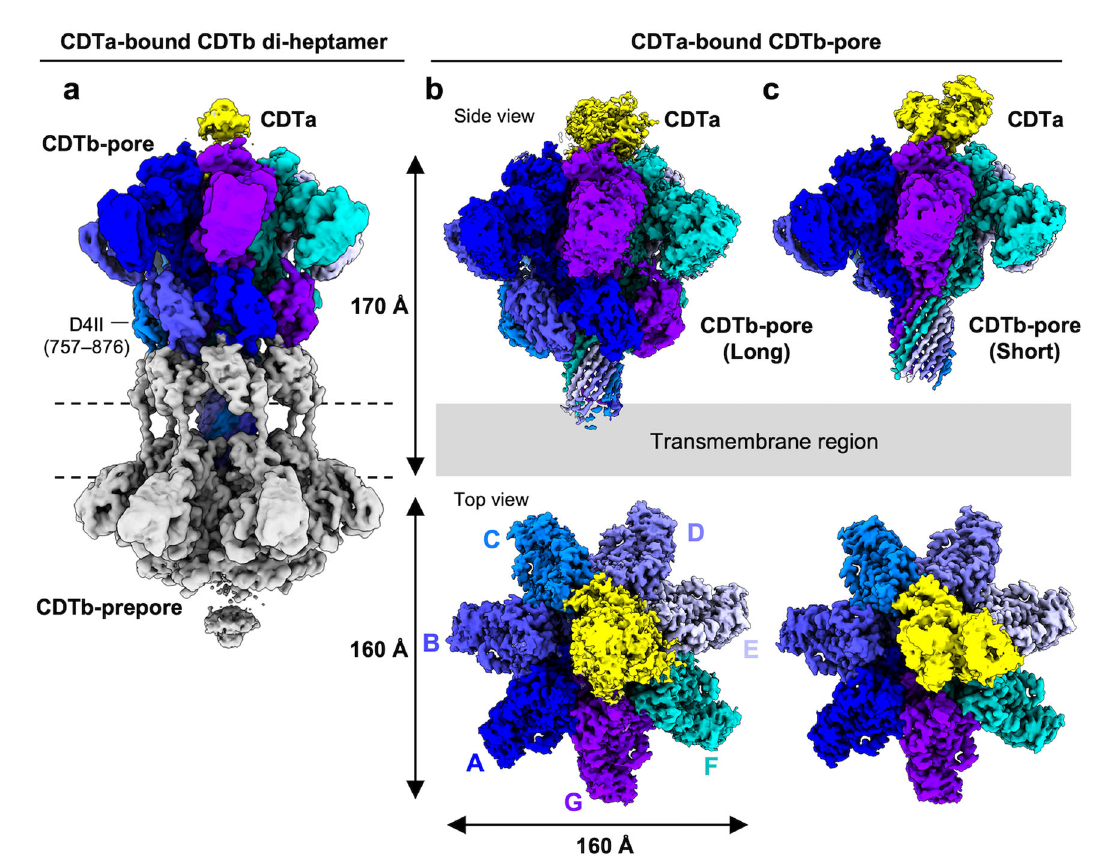
Fig. 2 | Cryo-EM density maps of CDTa-bound CDTb-pores. Transmembrane regionisshownasdottedlines(left)orgrayrectangle (right). a CDTa-bound CDTb